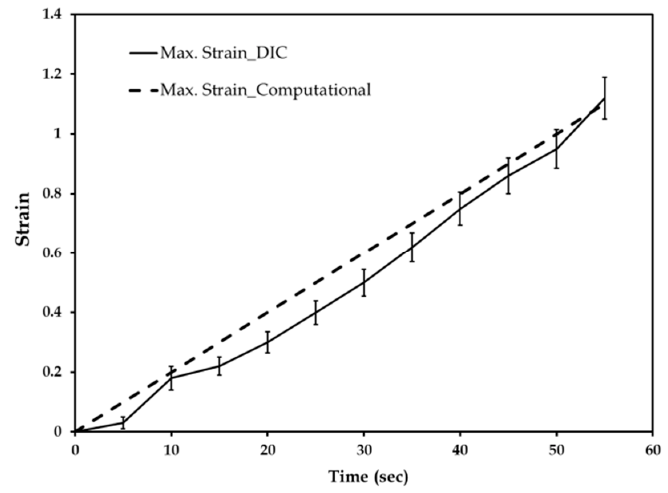
Figure 21. Maximum local strains measured around the transverse wound under tensile stretching in the computational model and compared with DIC measurements.